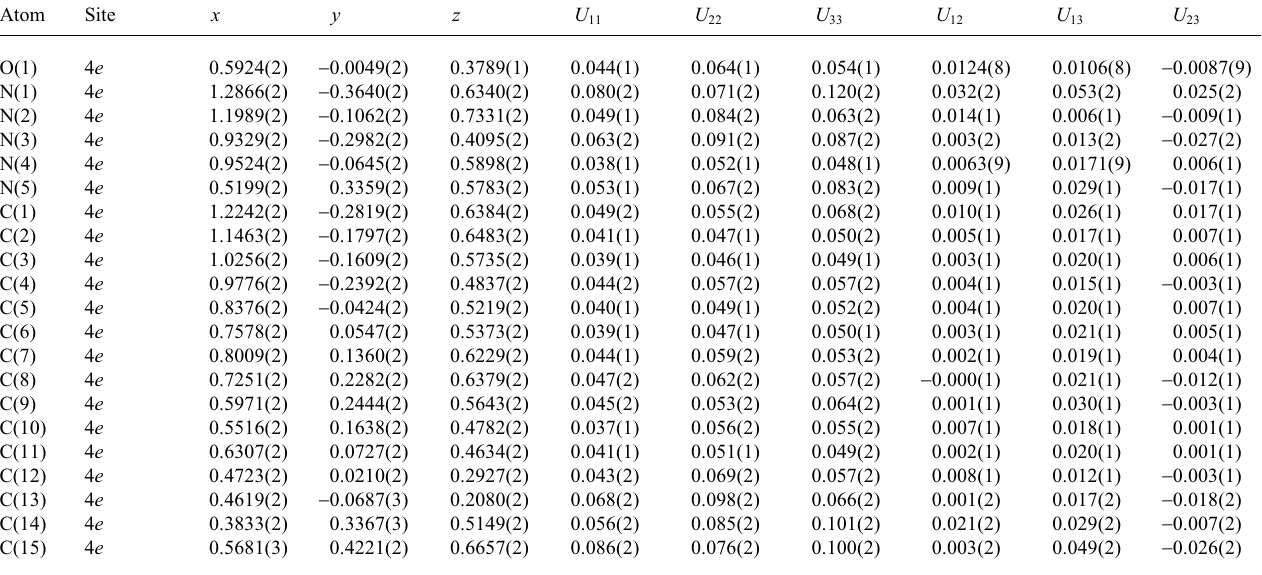
Table 3. Atomic coordinates and displacement parameters (in Å 2